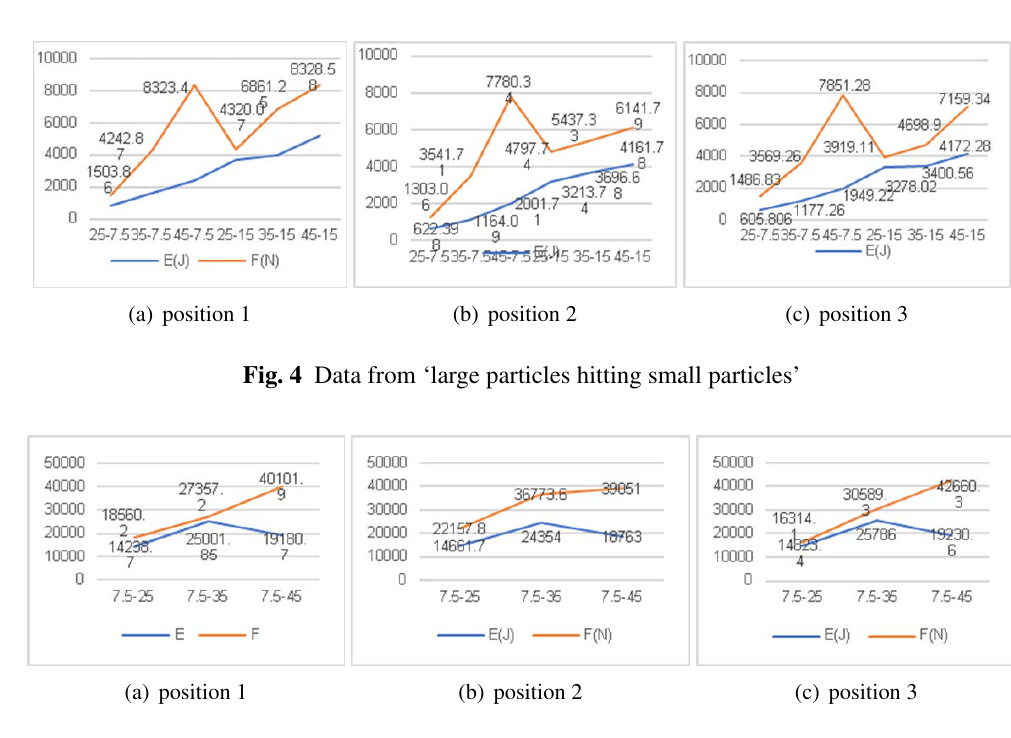
Fig. 3 Diagram of the waterfall inlet and the impeller